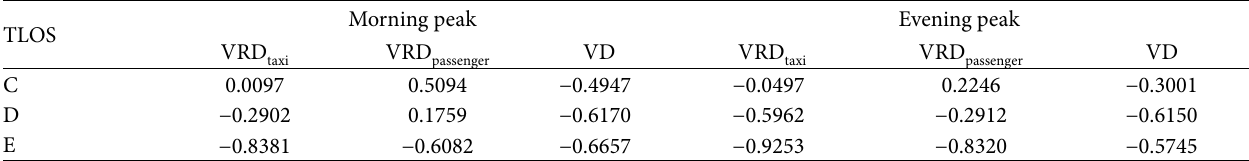
Table 4: The variation of the spatio-temporal distribution of supply and demand.